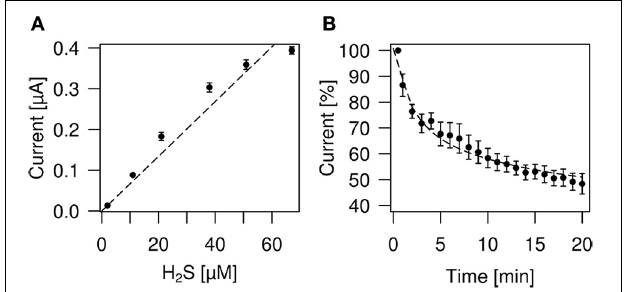
FIGURE 1 | Determination of H 2 S concentrations and loss of H 2 S by evaporation. (A) Plot of the H 2 S concentrations derived from NaHS donor vs. H 2 S sensor current (nA). The relationship is linear up to about 50 μ M H 2 S, respectively 226 μ M NaHS (stippled line fitted to data points). (B) Measurement of H 2 S evaporation from physiological bath solution. The plot shows sensor current readings vs. time. One hundred percent indicates the beginning of the measurement which started immediately after preparation of the